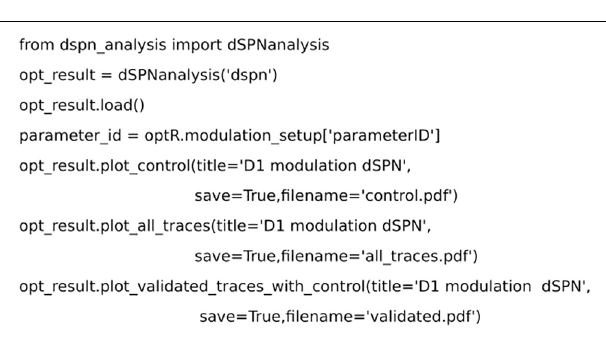
FIGURE 6 | Code for analyzing the results from the optimization using dSPNanalysis . dSPNanalysis ( inheritance from OptimiseAnalysis class) loads the results from the optimization. The results can be plotted by custom methods and the final modulation is